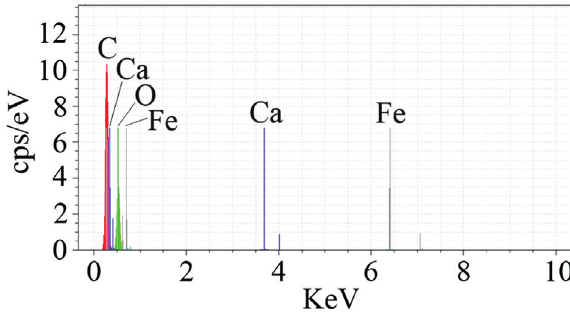
Figure 7: EDS spectrum of the synthesized